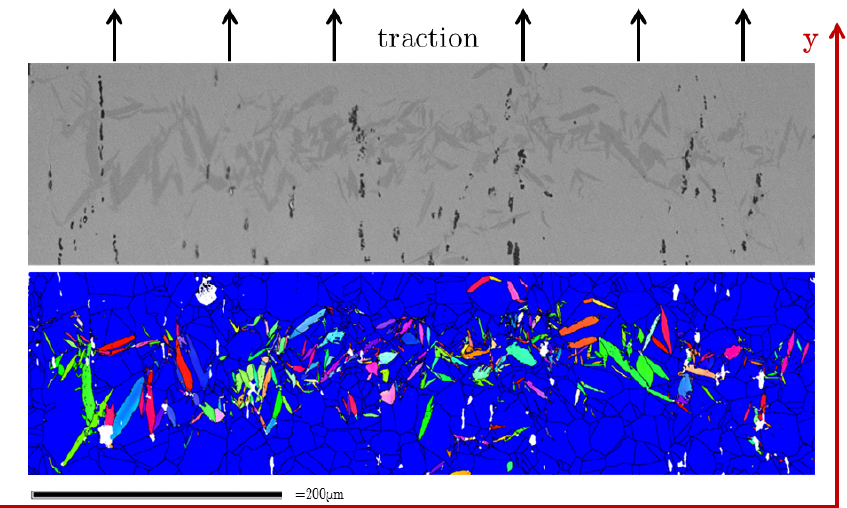
Figure 3. EBSD map of a column of martensite with the austenite in blue and the martensite in Euler colour coding and below, bright-field optical micrograph of the corresponding zone. The black arrows indicate the traction direction and the red axis can be related to those in Figure